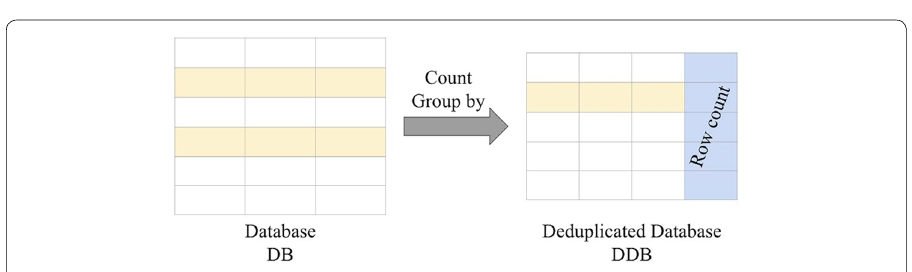
Fig. 5 The deduplication